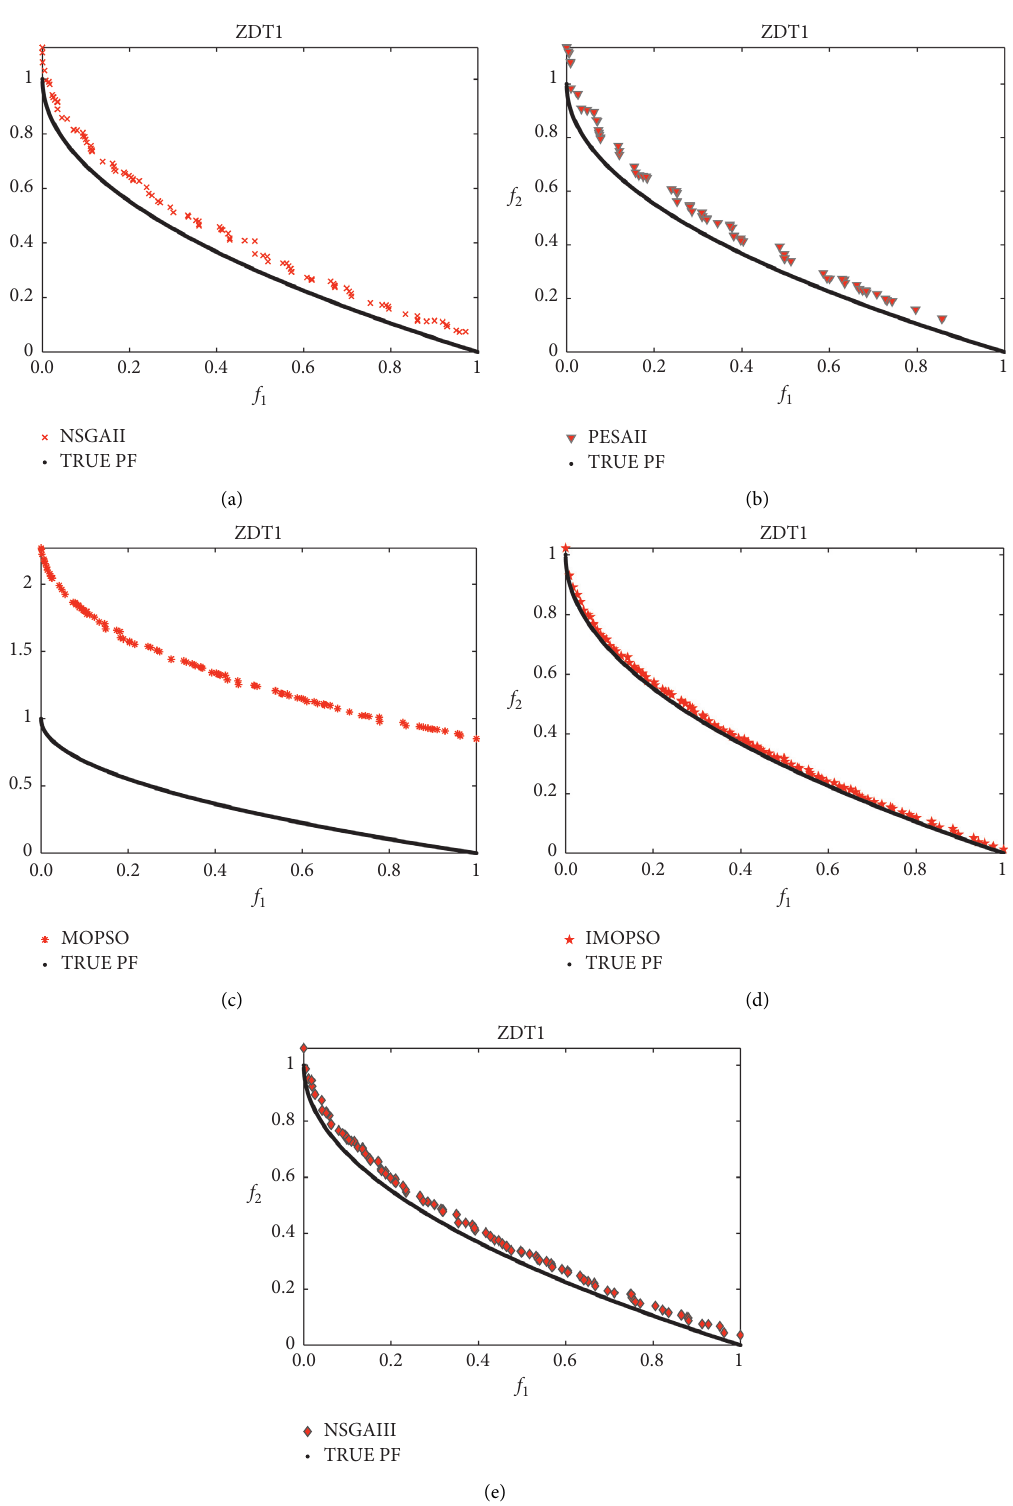
Figure 2: ZDT1 test